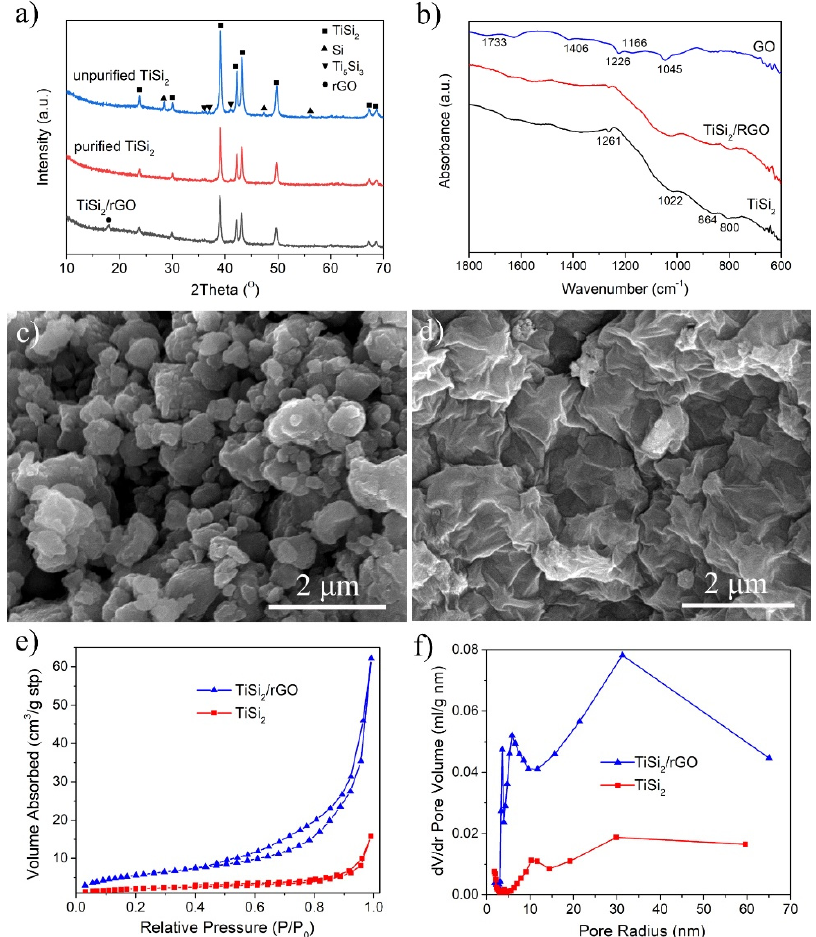
Figure 1. ( a ) XRD patterns of TiSi 2 , purified TiSi 2 and TiSi 2 /RGO; ( b ) FT-IR spectra of graphene oxide (GO), TiSi 2 and TiSi 2 /RGO; SEM micrographs of ( c ) TiSi 2 and ( d ) TiSi 2 /RGO; ( e ) N 2 adsorption- desorption isotherms and ( f ) pore size distributions of TiSi 2 and TiSi 2